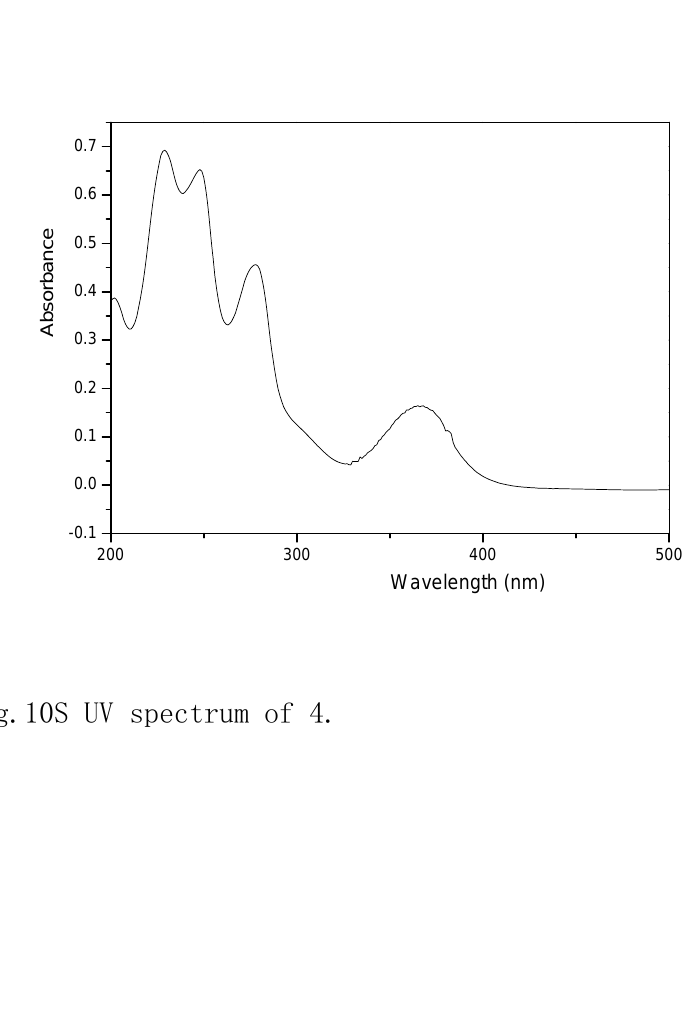
Fig.9S IR spectrum of 4.